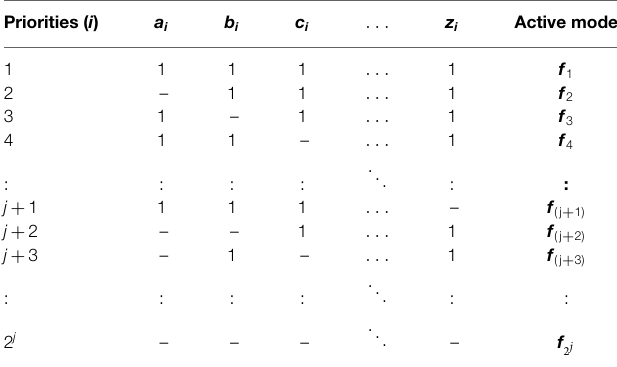
the null space of the stacked Jacobian of all the higher